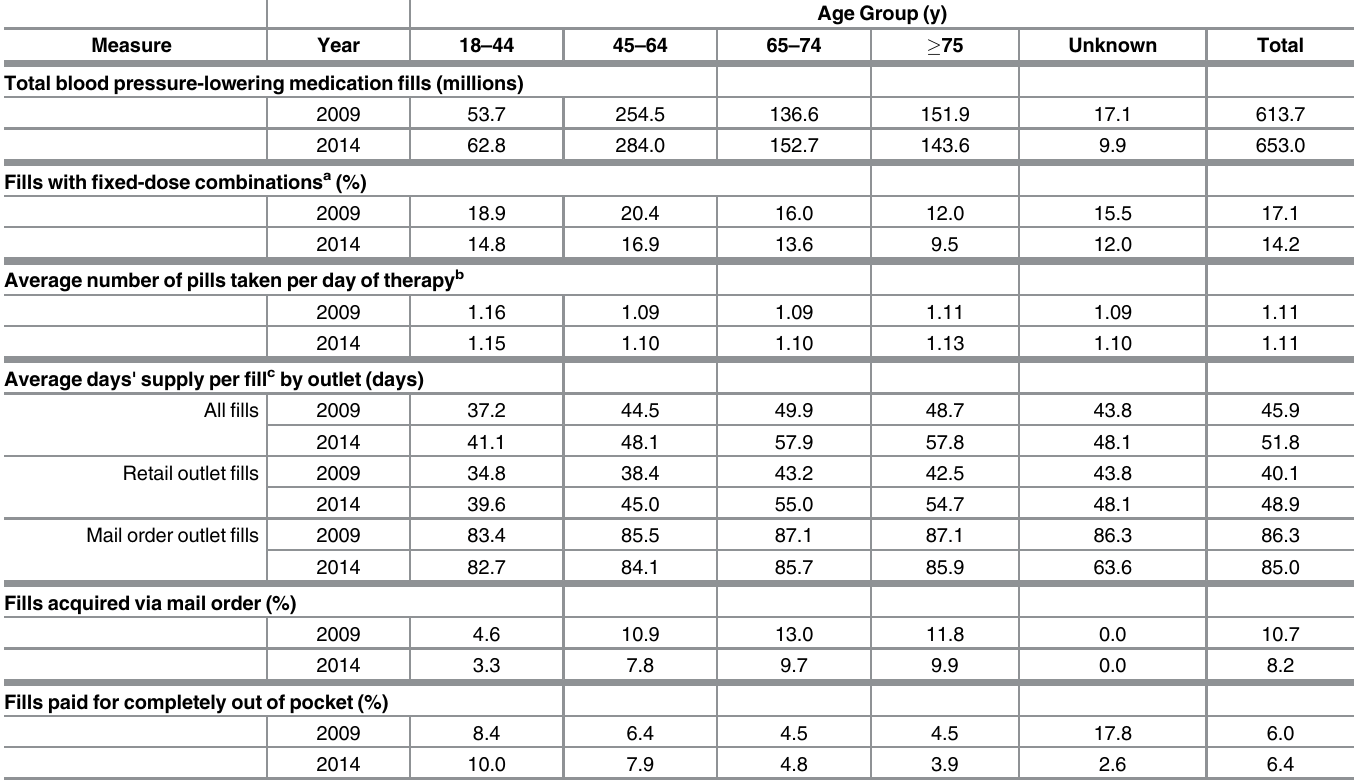
Table 1. Prescription- and payment-related Factors that Promote Adherence to Blood Pressure-lowering Medications by Age Group, 2009 and 2014.